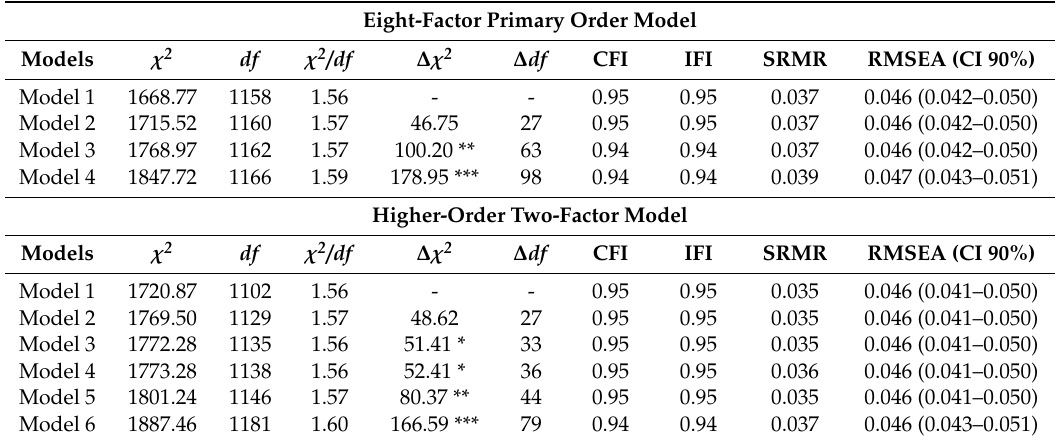
Table 1. Multi-group Gender Invariance Analysis.